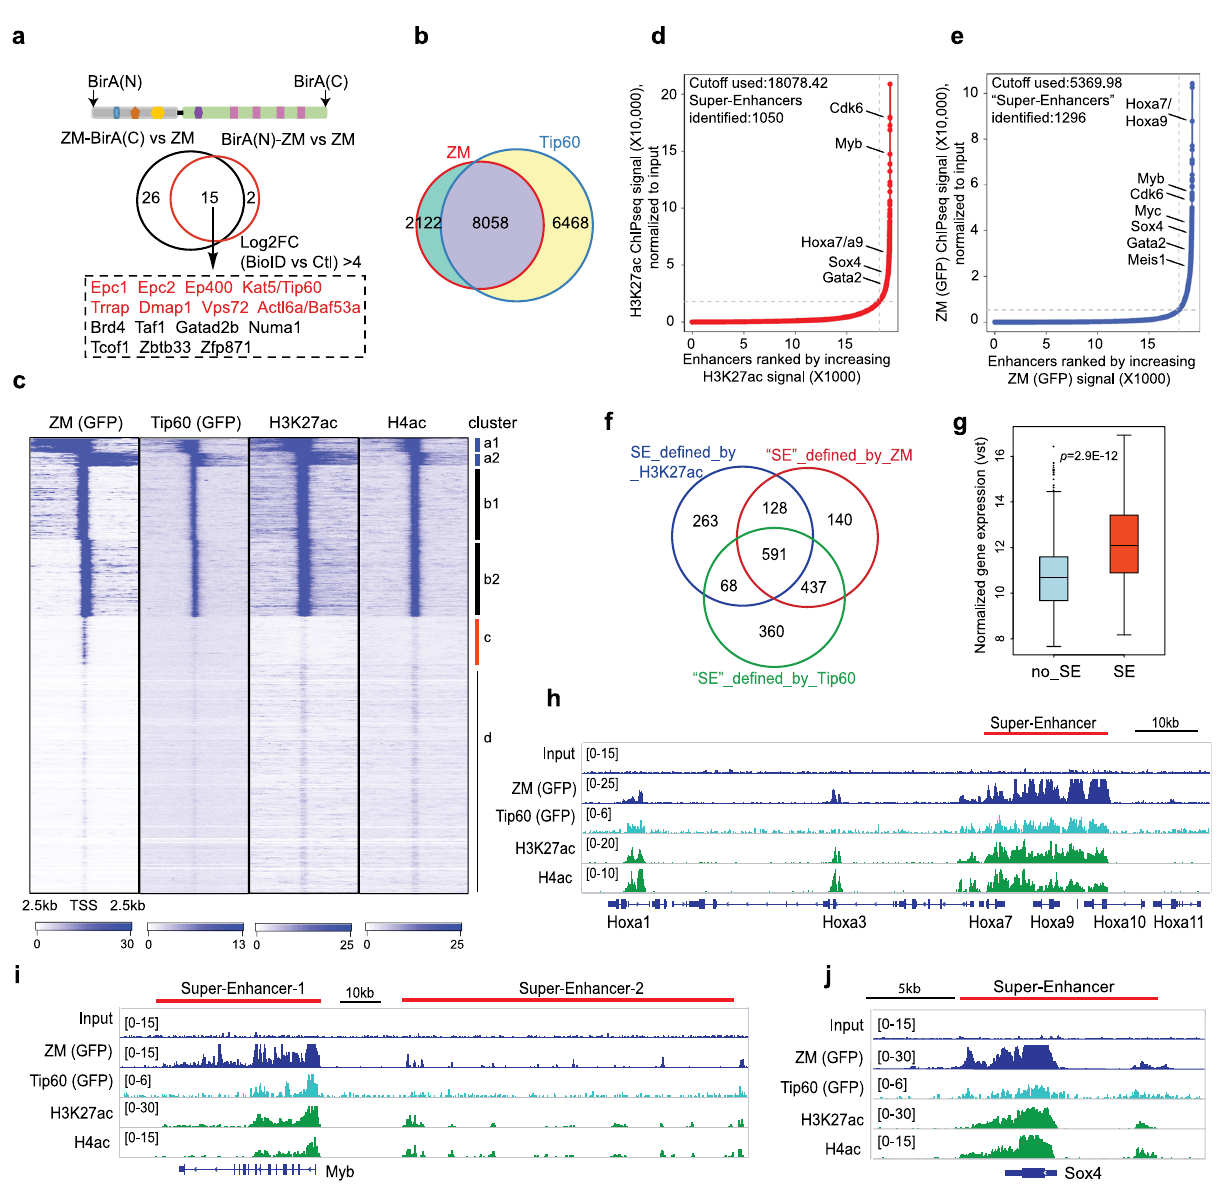
Fig. 4 ZM interacts with the NuA4/Tip60 complex, generating super-enhancers characterized by dense histone acetylation, typically seen at proto- oncogenes. a Venn diagram shows the ZM-interacting proteins (bottom panel, within dashed frame) identi fi ed from two independent experiments of BioID followed by mass spectrometry using murine HSPCs transduced with ZM tagged by a BirA ligase at either its N-terminus or C-terminus (top panel). HSPCs immortalized by ZM without a BirA tag were used as negative control (with a cutoff of log2[fold-change]>4). b Venn diagram displaying overlap between ZM and Tip60 ChIP-seq peaks. c Clustered heatmaps showing co-localization of ZM, Tip60, H3K27ac and H4ac at promoter-proximal regions ( + / − 2.5 kb from TSS) in ZM-transformed AML cells. Four clusters (labeled as a to d, same as Fig. 3e) were produced based on their distinct ZM ChIP-seq signals. TSSs on the two DNA strands are labeled as 1 and 2 (such as a1/2 and b1/2), respectively. d , e Hockey-stick plot shows distribution of input-normalized ChIP-seq signals of H3K27ac ( d ) or ZM ( e ) across all enhancers annotated by H3K27ac peaks (promoter-proximal regions or TSS + / − 2.5 kb were excluded). Representative proto-oncogenes associated with super-enhancers (SEs), called by ROSE 83,84 , are indicated. f Venn diagram illustrates overlaps among SEs called based on H3K27ac, ZM or Tip60 ChIP-seq signals. g Boxplot showing overall expression levels of genes directly upregulated by ZM, either SE-associated ( n = 101) or without SE (no_SE, n = 895). The p value was calculated by two-sided Student ’ s t test. The line in the middle of the box marks the median. The vertical size of box denotes the interquartile range (IQR). The upper and lower hinges correspond to the 25th and 75th percentiles. The upper and lower whiskers extend to the maximum and minimum values that are within 1.5 × IQR from the hinges. Outliers beyond the whiskers are plotted as circles. h – j IGV view of normalized ChIP-seq signals at the indicated gene. SEs de fi ned by H3K27ac are depicted with a red bar. The read counts were fi rst normalized to RPGC and then normalized to